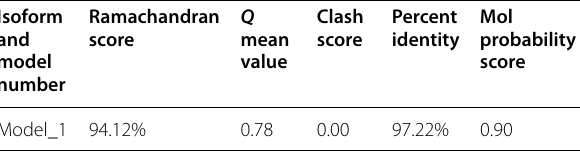
Table 3 Homology modeling data of β-defensin 1 Isoform and model number